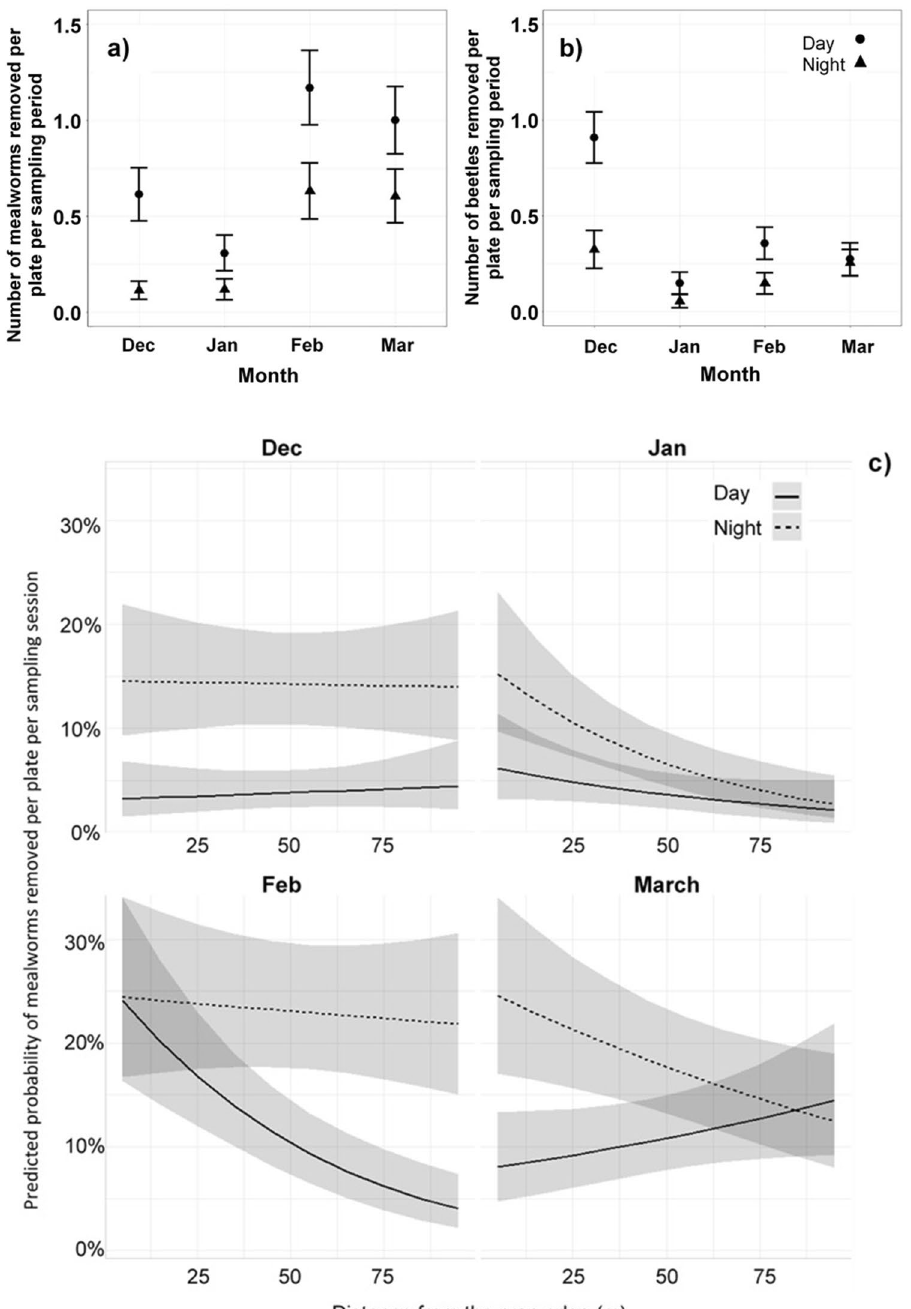
Figure 1. Mean number of ( a ) mealworms and ( b ) beetles removed, averaged over feeding station and sampling session by month (with 95% confidence intervals) and ( c ) predicted removal of mealworms at increasing distances from the crop edge by time of day (day vs night) and month, showing the 3-way interaction. Shaded areas represent 95% confidence